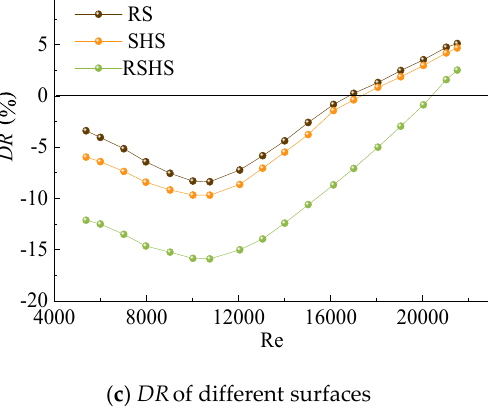
Figure 7. Fanning friction coefficient C f and drag reduction rate DR values .